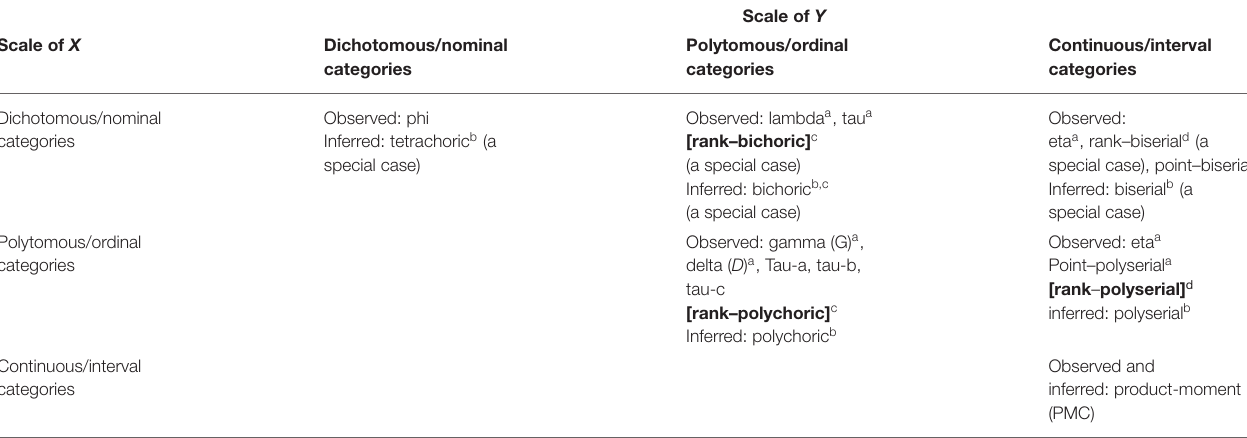
TABLE 1 | Coefficients of association by the scale properties of the observed variables X and